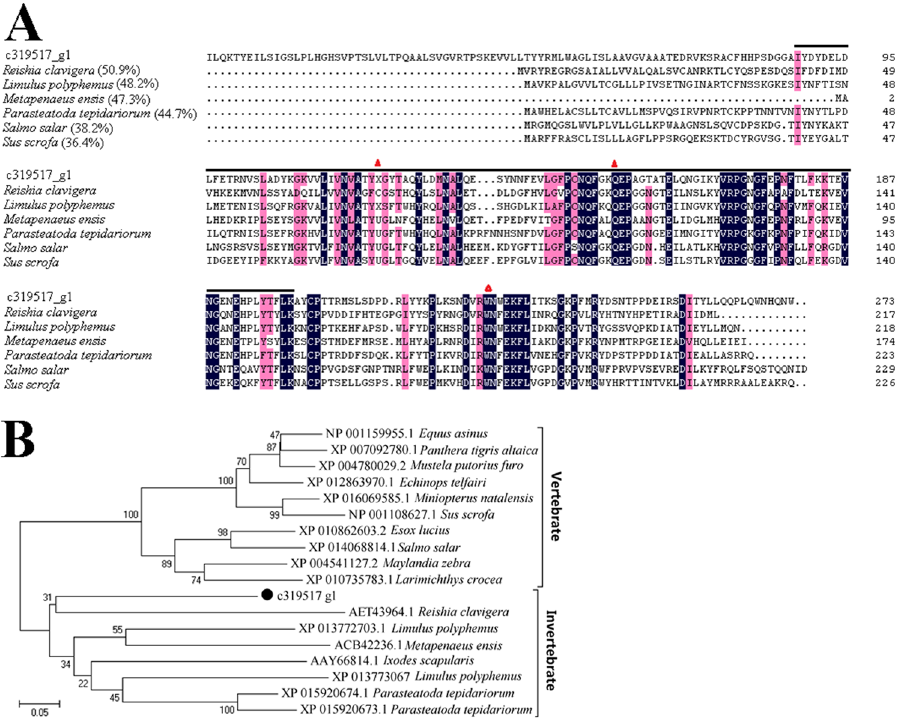
Figure 5. Sequence analysis of the glutathione peroxidase (GPx) (c319517_g1) from Rimicaris sp. ( A ) Sequence alignment of c319517_g1 and other GPx proteins from Reishia clavigera , Limulus polyphemus , Metapenaeus ensis , Parasteatoda tepidariorum , Salmo salar , and Sus scrofa . The numbers in brackets indicate overall sequence identities between c44577_g1 and the compared sequences; the consensus residues are in black; the residues that are ≥ 75% identical among the aligned sequences are in pink; the GSH peroxidase domain is indicated by the black line; the catalytic residues are represented by triangles. The GenBank Accession numbers of the aligned sequences are as follows: Reishia clavigera (AET43964), Limulus polyphemus (XP_013773067), Metapenaeus ensis , ACB42236; Parasteatoda tepidariorum , XP_015920674; Salmo salar , XP_014068814; Sus scrofa , NP_001108627. ( B ) Phylogenetic analysis of c319517_g1 (marked with “ ● ”) and other GPx sequences with 1,000 bootstrap